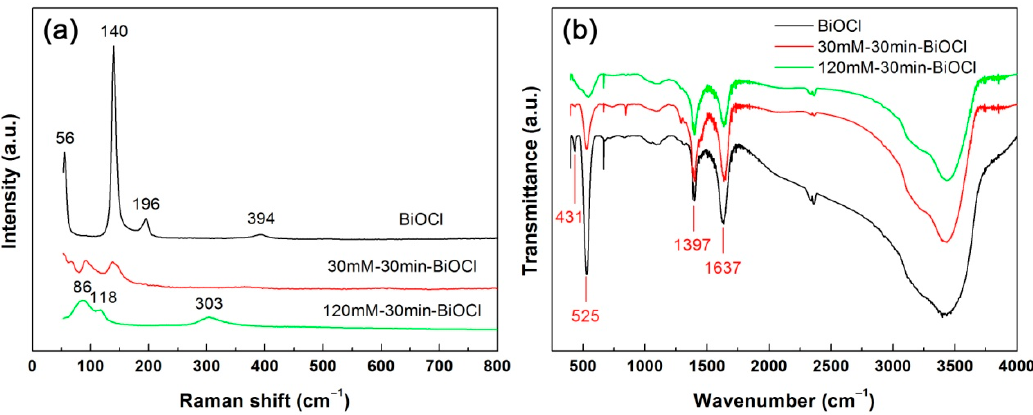
Figure 6. Raman spectra ( a ) and fourier transform infrared (FTIR) spectra ( b ) of pristine BiOCl, 30mM- 30min-BiOCl and